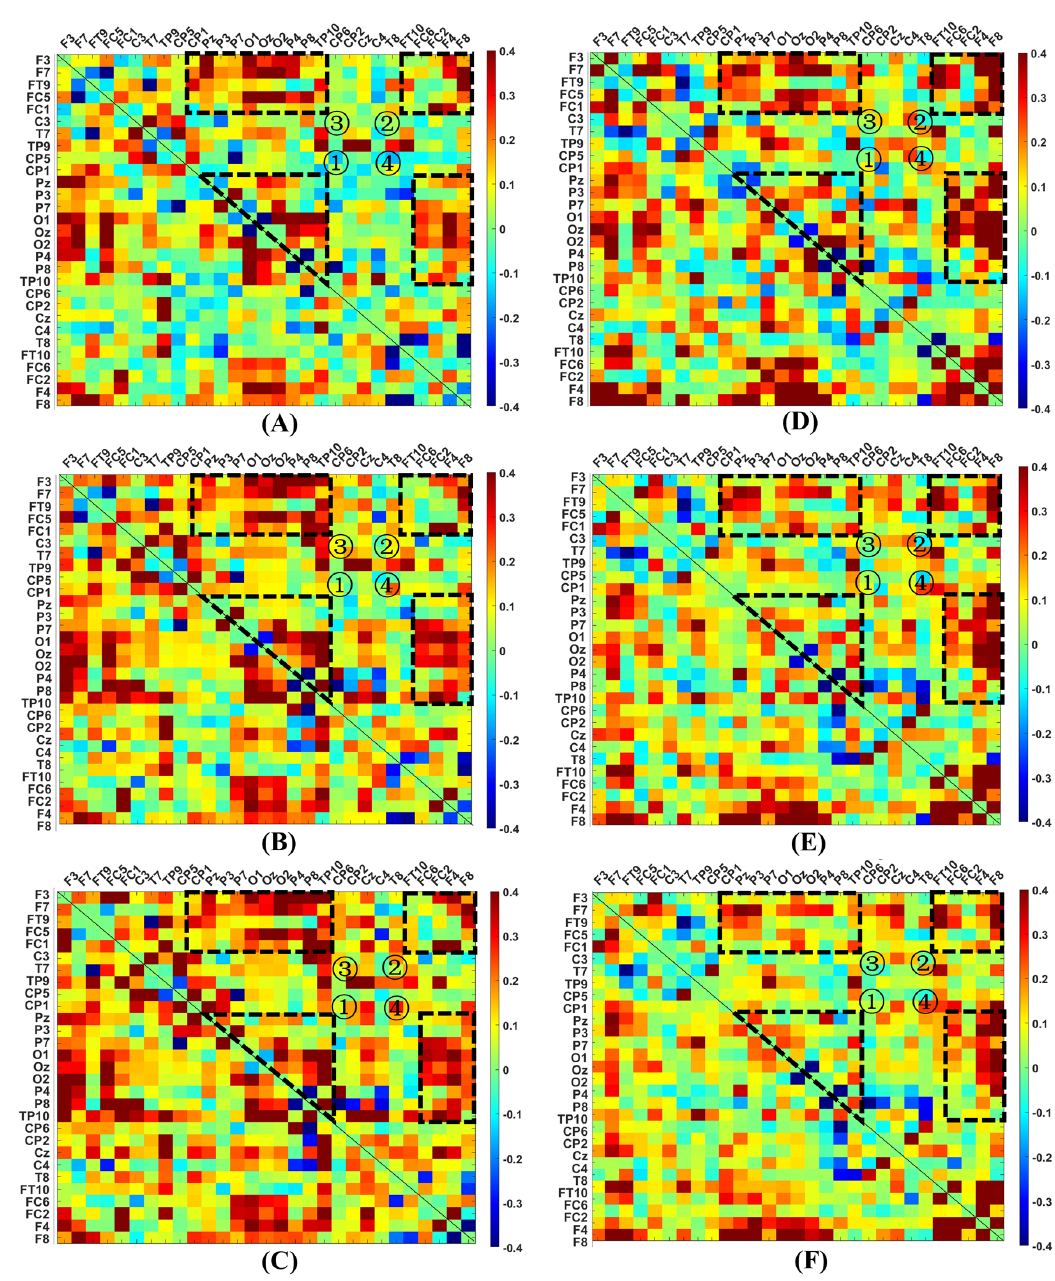
Figure 3. MI difference between stages three and one, and between stages four and one at different frequency bands: ( A ) MI difference between stages three and one in the beta band; ( B ) MI difference between stages three and one in the low gamma band; ( C ) MI difference between stages three and one in the high gamma band; ( D ) MI difference between stages four and one in the beta band; ( E ) MI difference between stages four and one in the low gamma band; ( F ) MI difference between stages four and one in the high gamma band. Four blocks of improvement were marked as ① – ④ .